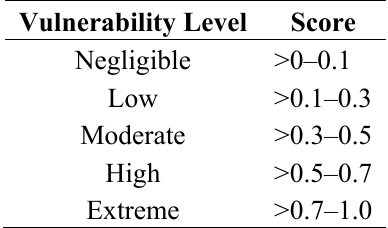
Table 3. Aquifer vulnerability